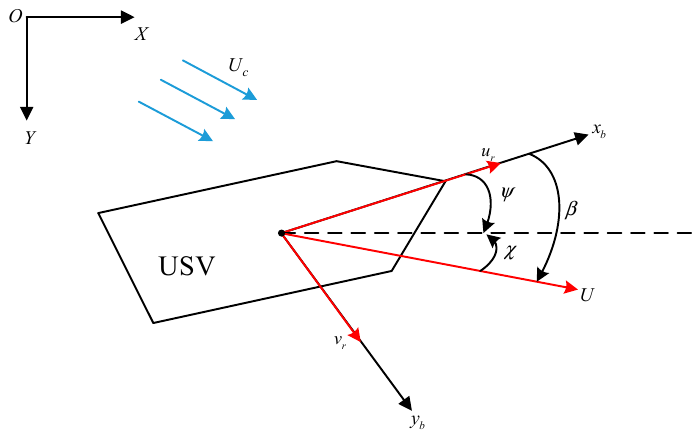
Figure 1. Schematic diagram of unmanned surface vehicles (USV) motion with 3 degrees of freedom (DOF) on the horizontal plane.